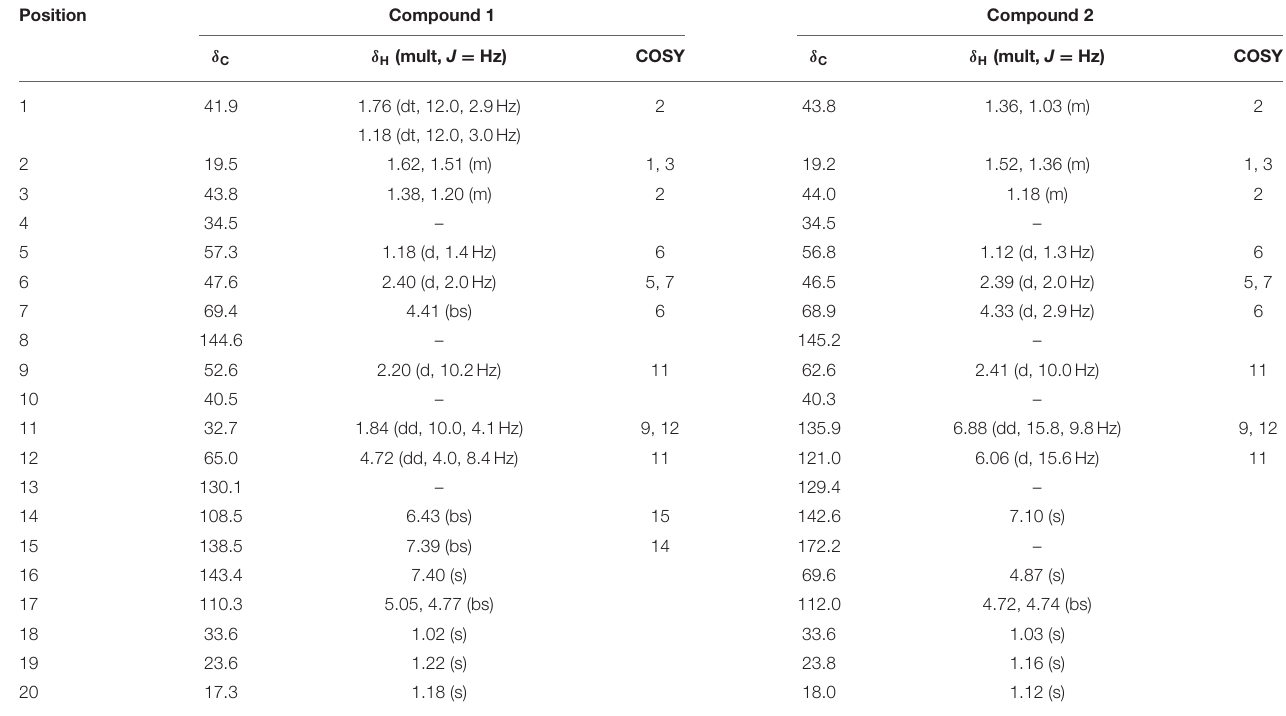
TABLE 1 | 1 H NMR and 13 C NMR data of compounds 1 a and 2 a